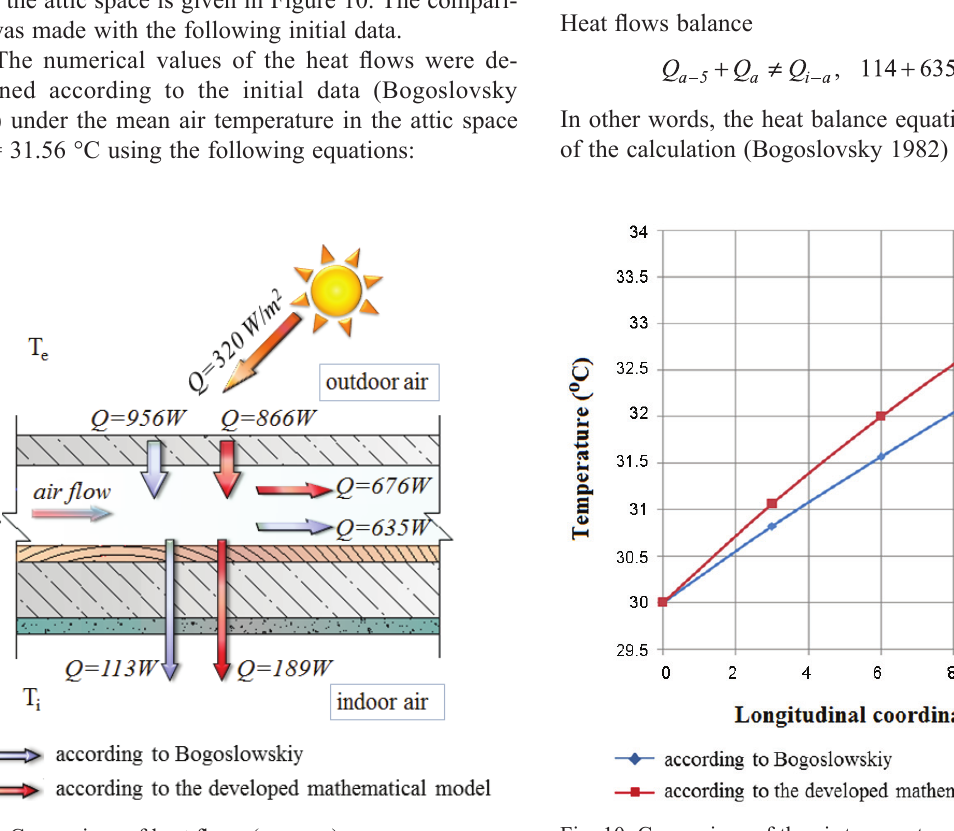
Fig. 10. Comparison of the air temperature in the attic space